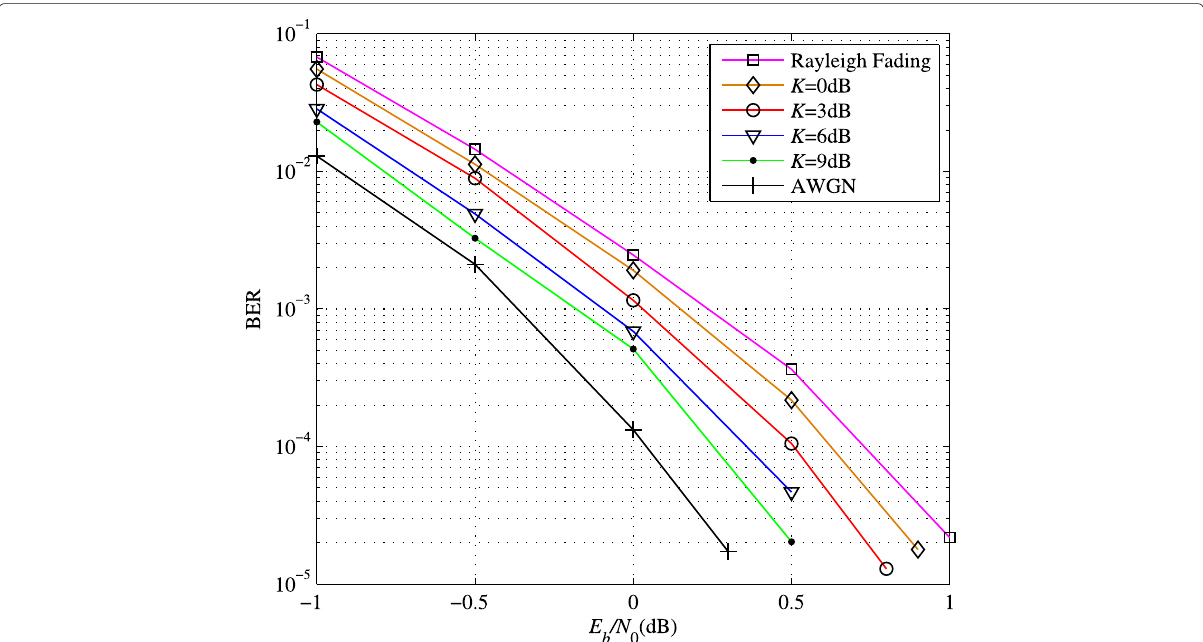
Fig. 4 BER performance of polar-coded STTD system corresponding to 2 × 2 MIMO. The bit error rate performance of polar-coded STTD system with two transmit antennas and two receive antennas. The Rician K -factors are various, which include the positive infinity (AWGN) and negative infinity (Rayleigh)